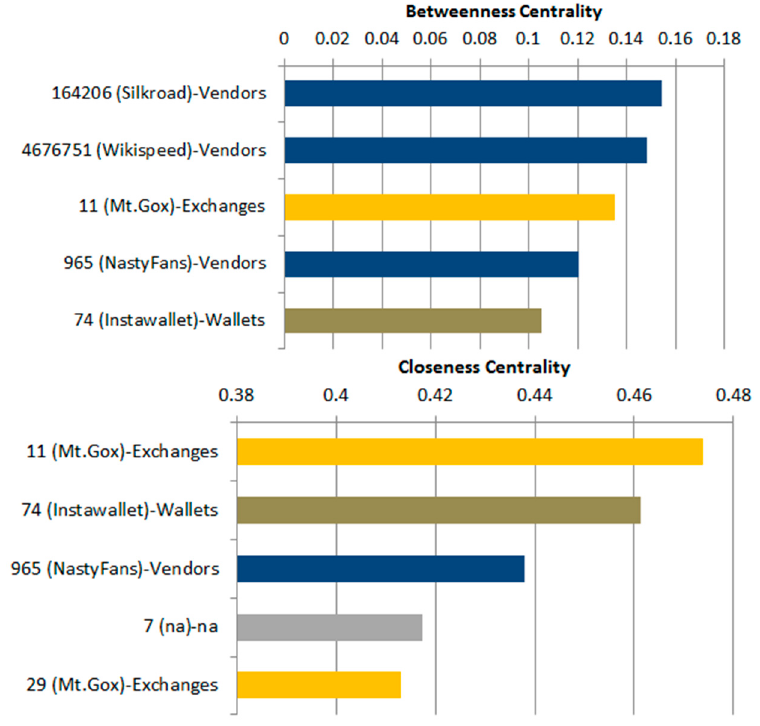
Figure 31. Betweenness and Closeness Centrality for the Vendors Business.